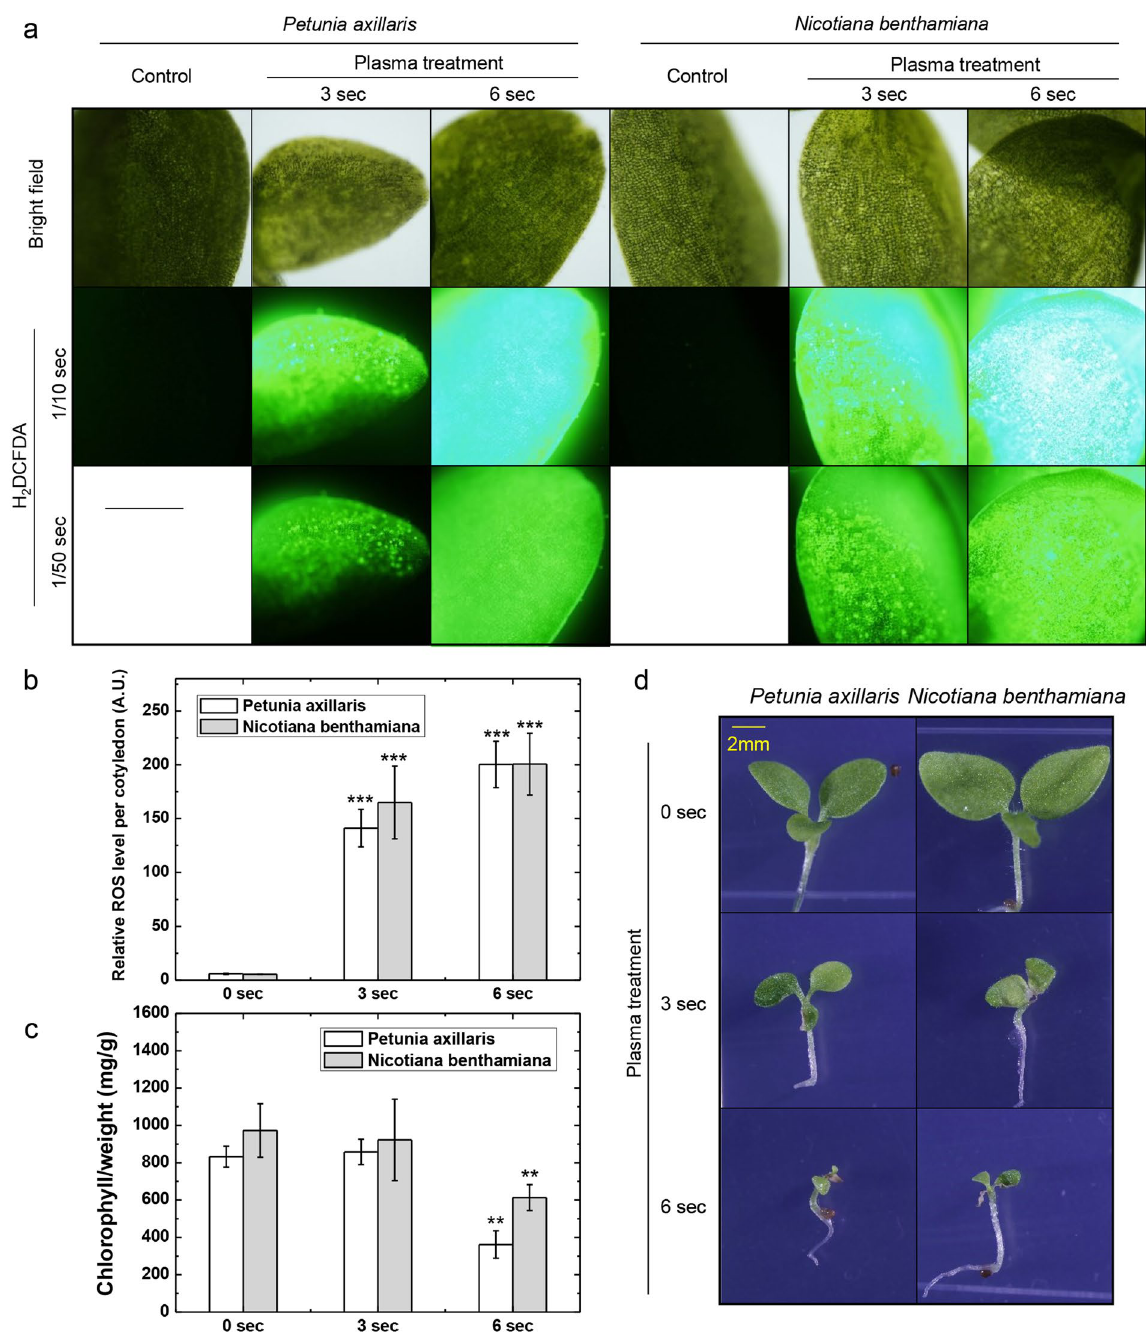
Figure 7. Petunia and tobacco seedlings treated with plasma accumulates ROS and induces cell death. ( a ) DCFDA image of plasma treated petunia and tobacco right after plasma treatment. Time indication under H 2 DCFDA indicates exposure time (sec.) Scale bar = 500 um. Representative image were determined from 5 experiments for each conditions. ( b ) Relative ROS level was measured in direct plasma treated seedlings and indirectly treated samples. To measure ROS level, we used 5 cotyledons treated with indicated conditions and DCFDA signal intensity were measured with same exposure time taken fluorescence image data. Signal was measured for whole cotyledon as mean grey value. Error bar = SD Student’s t-test were used to indicate significant difference from Mock treatment of each plant, * < 0.05, ** < 0.01, *** < 0.001. ( c ) Total chlorophyll level from samples after 5 days. 0 s, 3 s, and 6 s indicates plasma treatment time (seconds). Error bar = SD. Student’s t-test were used to indicate significant difference from Mock treatment of each plant, * < 0.05, ** < 0.01, *** < 0.001. ( d ) Phenotype of plasma treated seedlings after 5 days of plasma treatment in long-day incubation. Scale bar = 2 mm. Representative image were determined from 5 experiments for each